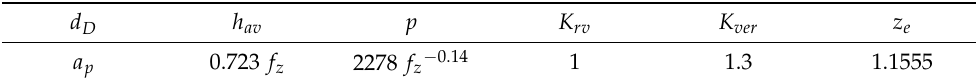
Table 3. Milling force parameter.